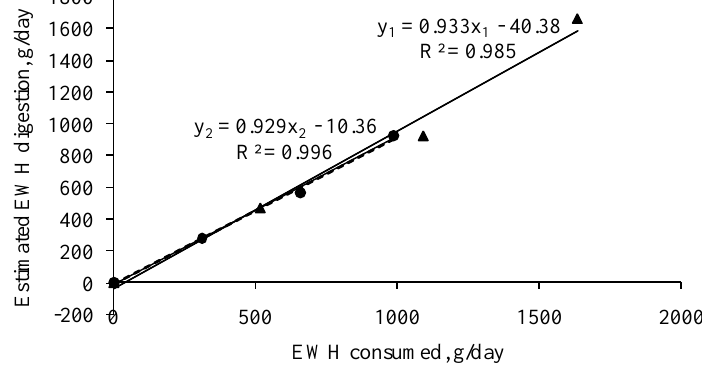
Figure 1. Regression between OM (y 1 ), NDFom (y 2 ) consumed and digested coming from EWH in cattle fed different levels of EWH.